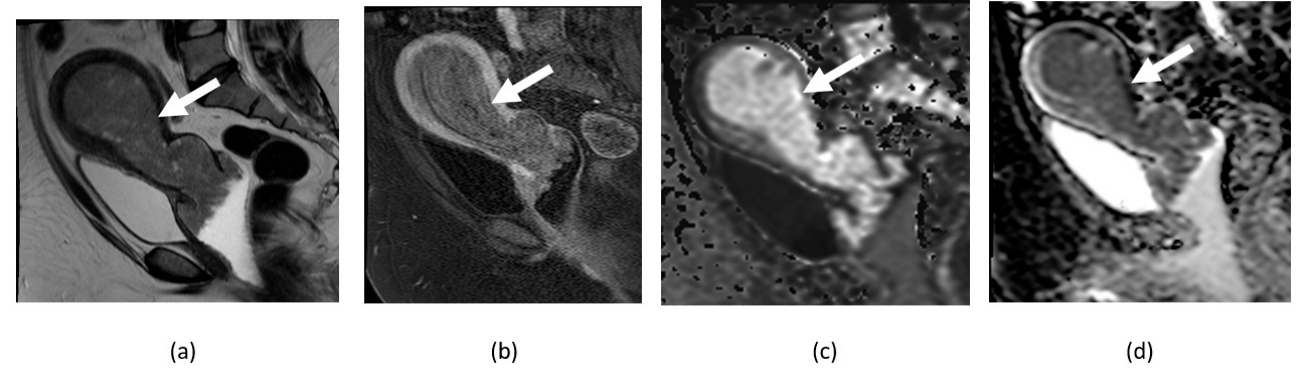
Figure 15. Sagittal T2-weighted ( a ), contrast enhanced T1-weighted ( b ), DWI ( c ), and ADC map ( d ) show a large intracavitary endometrial mass (arrows) with cervical invasion from endometrial cancer showing restricted diffusion.